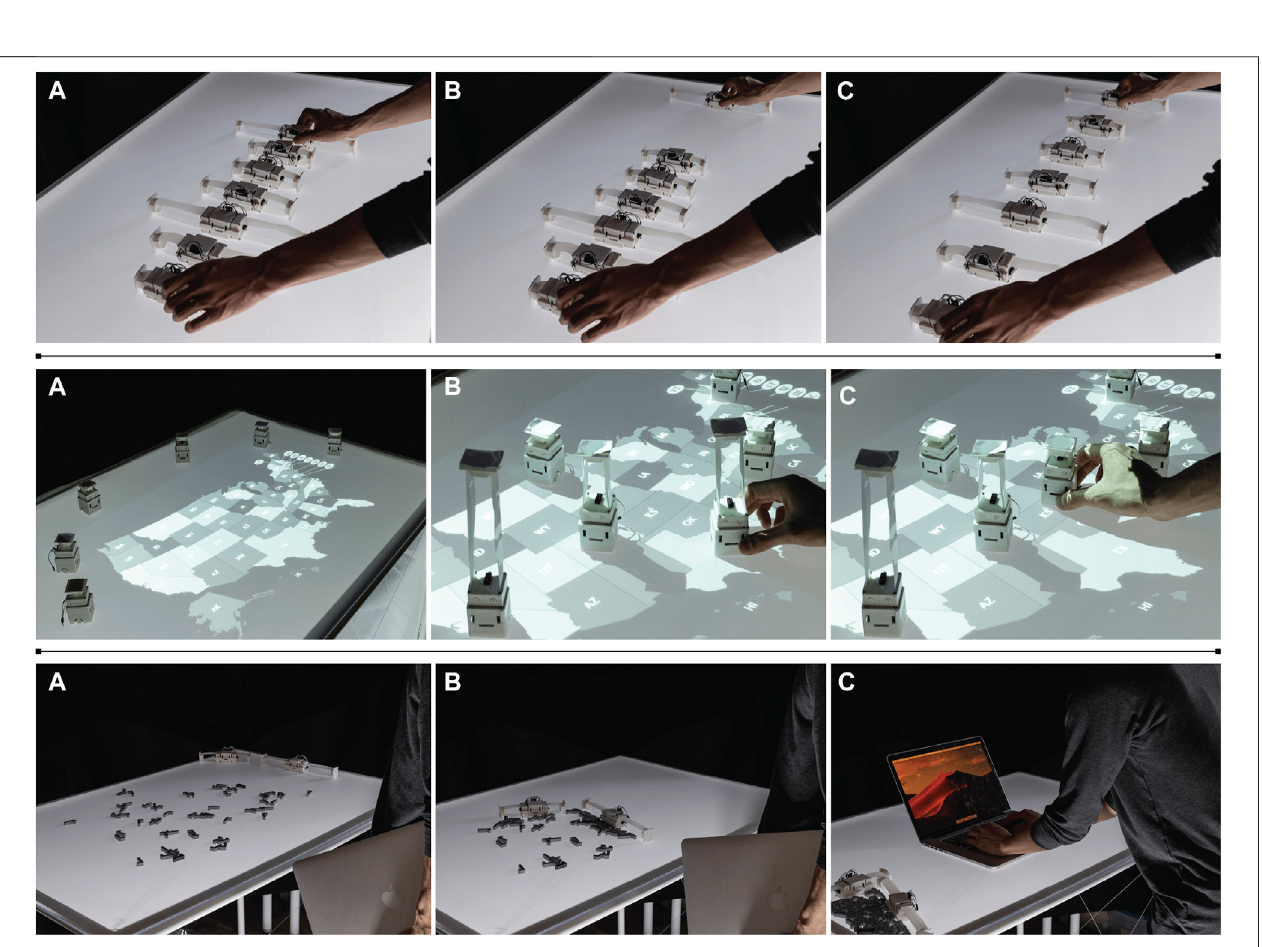
FIGURE15| Firstrow:Aninteractiveandanimatedsinewave. (A) Animatedsinewave. (B) Whentheusermovesoneelement, (C) theneachrobotcancollectively movetochangethespatialperiodofthewave.Secondrow:Embeddeddataphysicalizationonamap. (A) ProjectedUSmap. (B) Whentheuserselectsthedataset,the ShapeBots move topositionandvisualizedatawiththeirheights. (C) Whenmoved,therobotschangetheirheightsaccordinly.Thirdrow:Clean uprobots. (A) Adeskis fi lled with debris. (B) Two robots starts moving and wiping the debris. (C) Once the robots fi nish cleaning up, the user can start using the workspace.